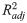
Relationship of mean fish abundance (May 2012‒October 2013) with altitude by flow regime and fish species.The lines correspond to linear (S. laietanus, top plot) or quadratic regressions (B. meridionalis, bottom plot) separated by flow regime. Linear r2 are 0.668 (perennial) and 0.620 (intermittent). Quadratic Radj2 are 0.407 (perennial) and 0.223 (intermittent). Sites T1‒T12 are located on Tordera mainstem; sites A1‒A3 are on the Arbúcies tributary. Squalius laietanus was not captured at sites T3, T5, T6, A1, and A2.